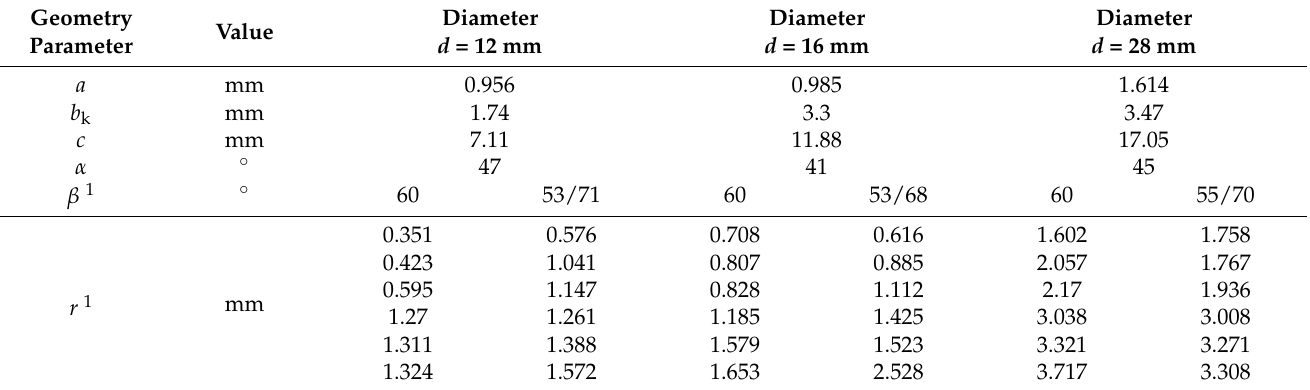
Table 5. Results of the tensile tests.